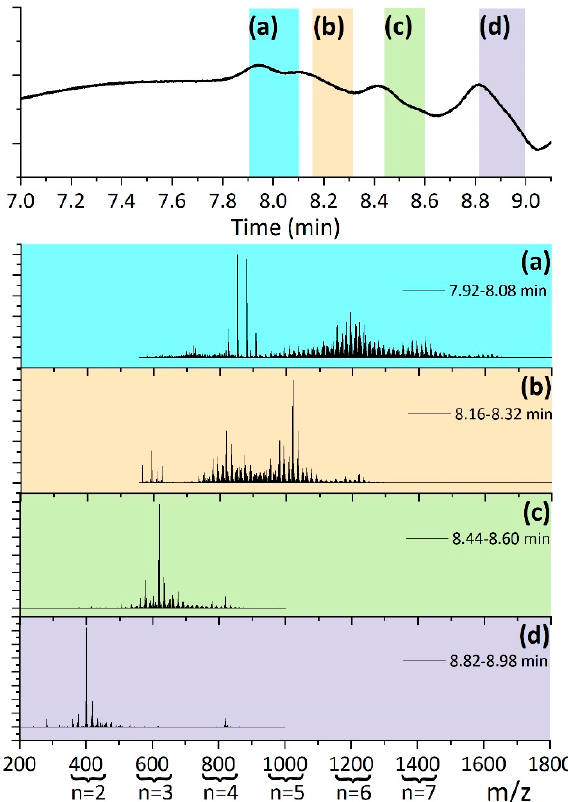
Figure 7. Chromatogram of the A6CC-90 sample obtained by GPC-HRMS. For each elution time range ( a ) 7.92–8.08 min, ( b ) 8.16–8.32 min, ( c ) 8.44–8.60 min and ( d ) 8.82–8.98 min the corresponding HRMS spectrum is displayed. The ranges are indicated by color bands in the GPC chromatogram. For reference, the number of repeating units (n) of the detected oligomers is given.